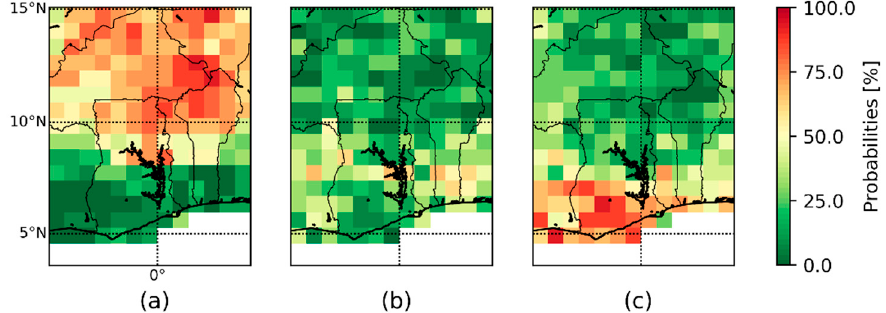
Figure 12. Relative frequency in percent (%) of the 15 ensemble members for the year 2001 of SYS4 by the classification into the categories: ( a ) “Below Average” ( p 1 ), ( b ) “Near Average” ( p 2 ) and ( c ) “Above Average” ( p 3 ).